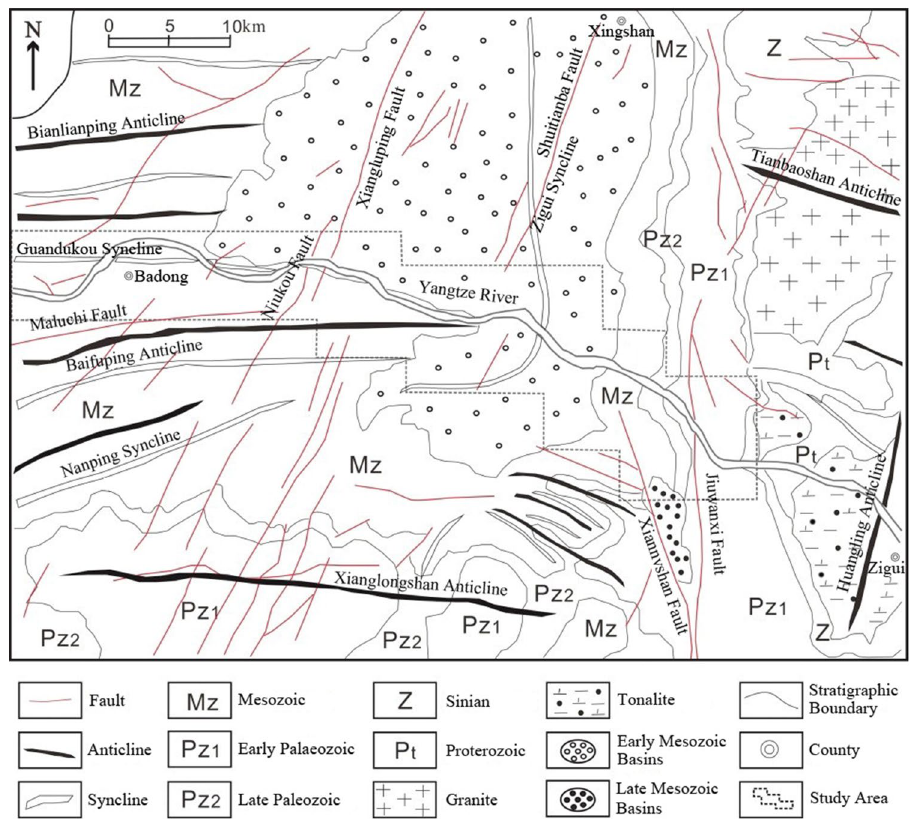
Figure 3. Geological map of the study area (Drawn with ArcGIS 10.8 software, and the URL is: https:// www. esri. com/ en- us/ arcgis/ about- arcgis/ overv iew).